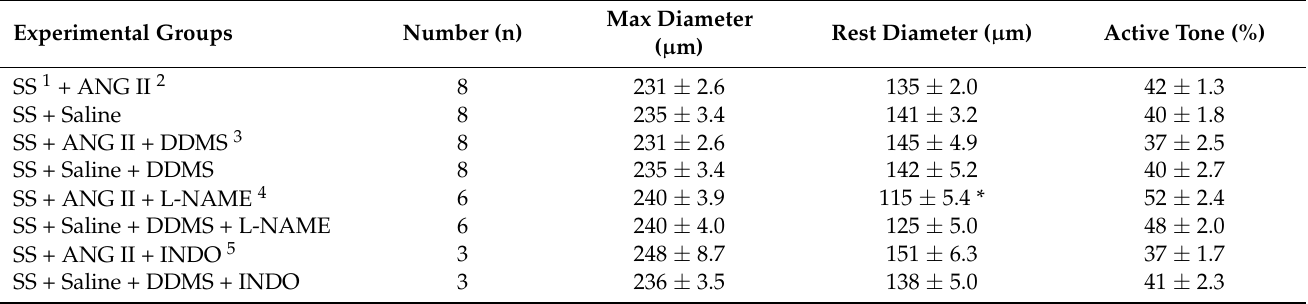
Table 2. MCA Diameters and Resting Tone in Dahl SS Rats with